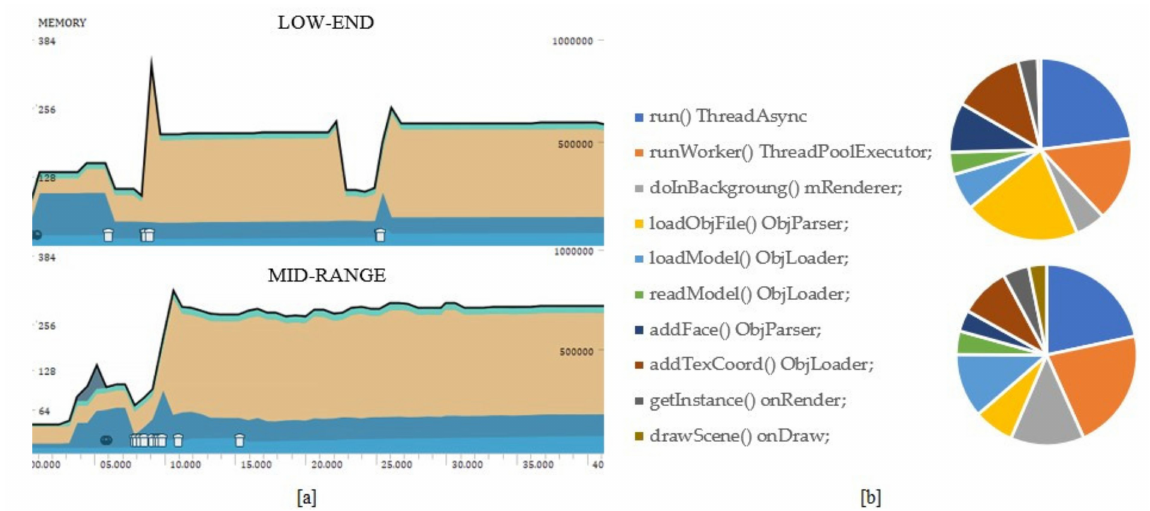
Figure 10. Memory profiling for the low-end and the mid-range device during an AR session with the 3D Model “CHURCH”: [ a ] 40 s timeline upon pattern recognition with the memory allocation of the main memory types, including Graphics (yellow) and Native (dark blue); [ b ] graphics objects and classes with the most heap